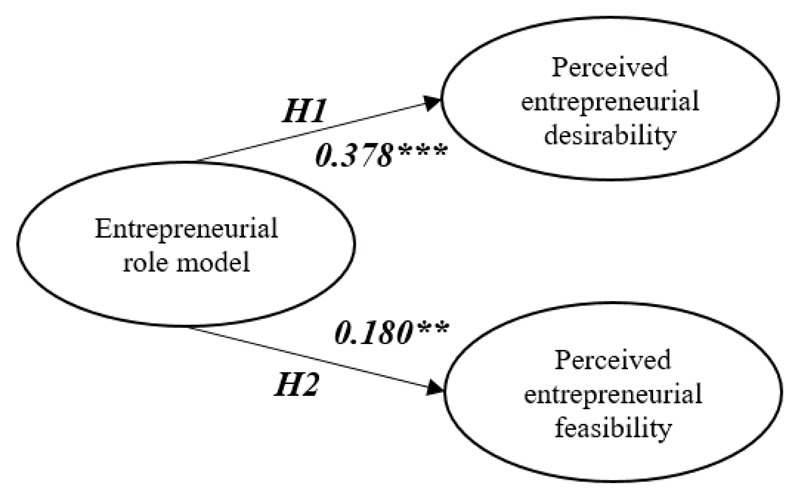
Results of the research modelsNotes: Standardised regression weights (SRW); significance codes: ***p < 0.001, **p < 0.01.